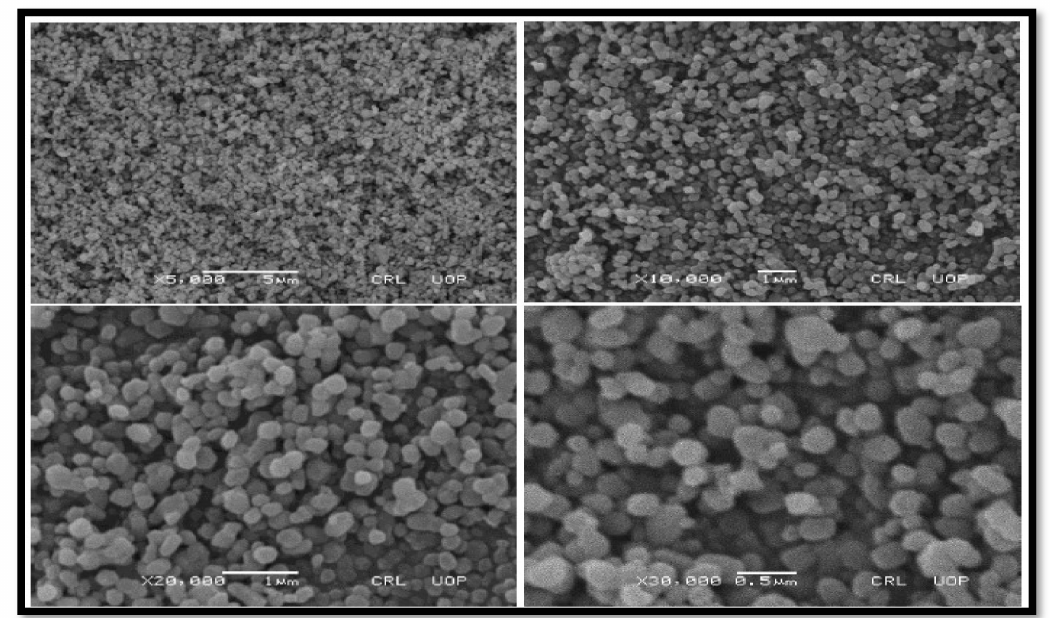
Figure 8. SEM images of TiO 2 with different